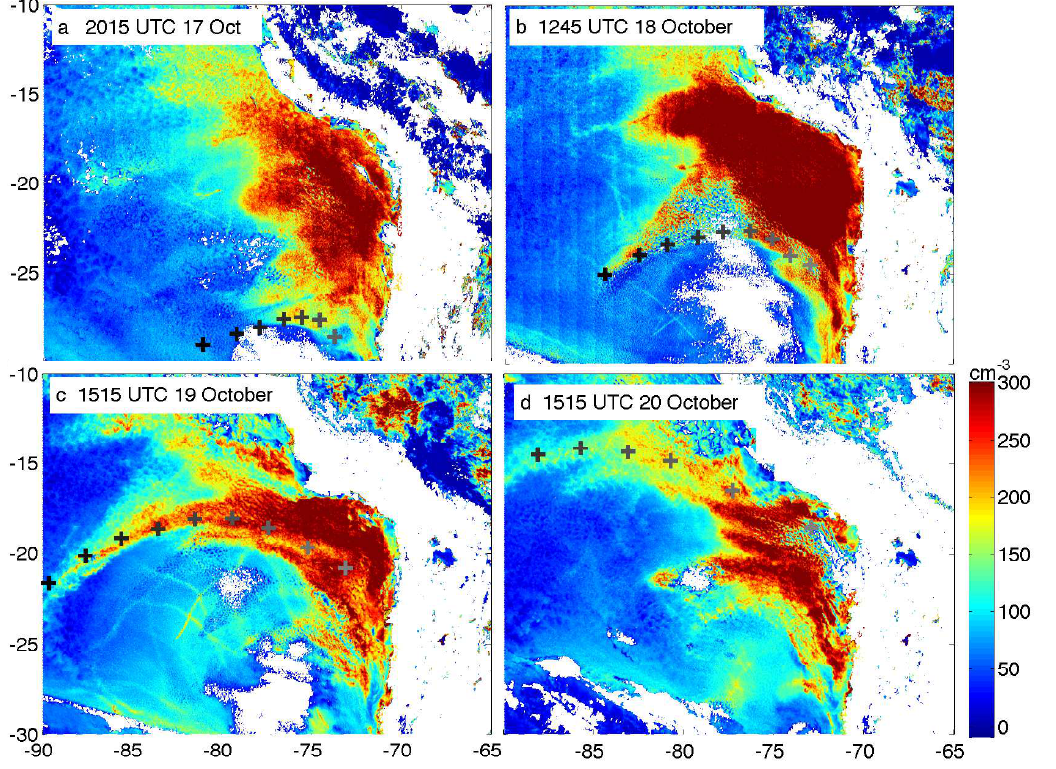
Fig. 2. Observations of Hook1 N d derived from GOES retrievals (Sect. 2.1) on (a) 17 October at 20:15UTC, (b) 18 October at 12:45UTC, (c) 19 October at 15:15UTC, and (d) 20 October at 15:15UTC. Markers (“+”) show points along ECMWF MBL 2-D (at 950hPa) forward and backward trajectories (see Appendix) initialized at locations along the hook on 18 October at